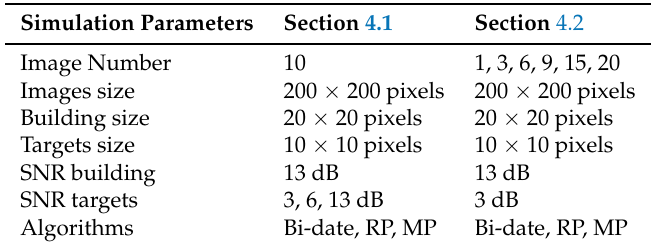
Simulation settings: with SNR (Signal-to-Noise ratio), RP (Random pixel), MP (Multi-temporal